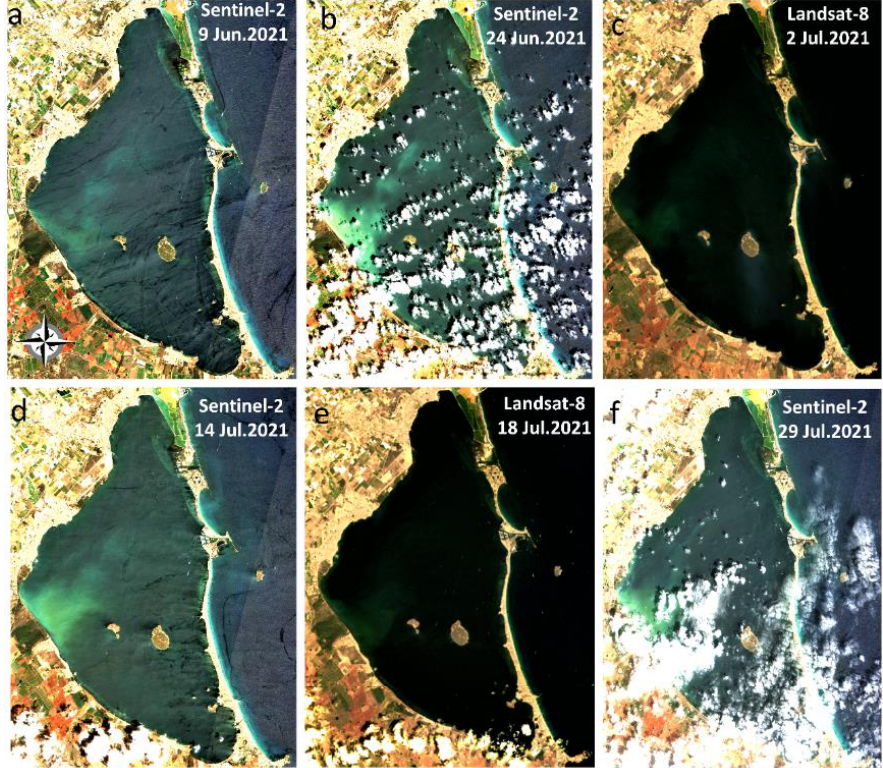
Figure 9. Sentinel-2 and Landsat-8 RGB (Red – Green – Blue) composite image acquired on ( a ) 9